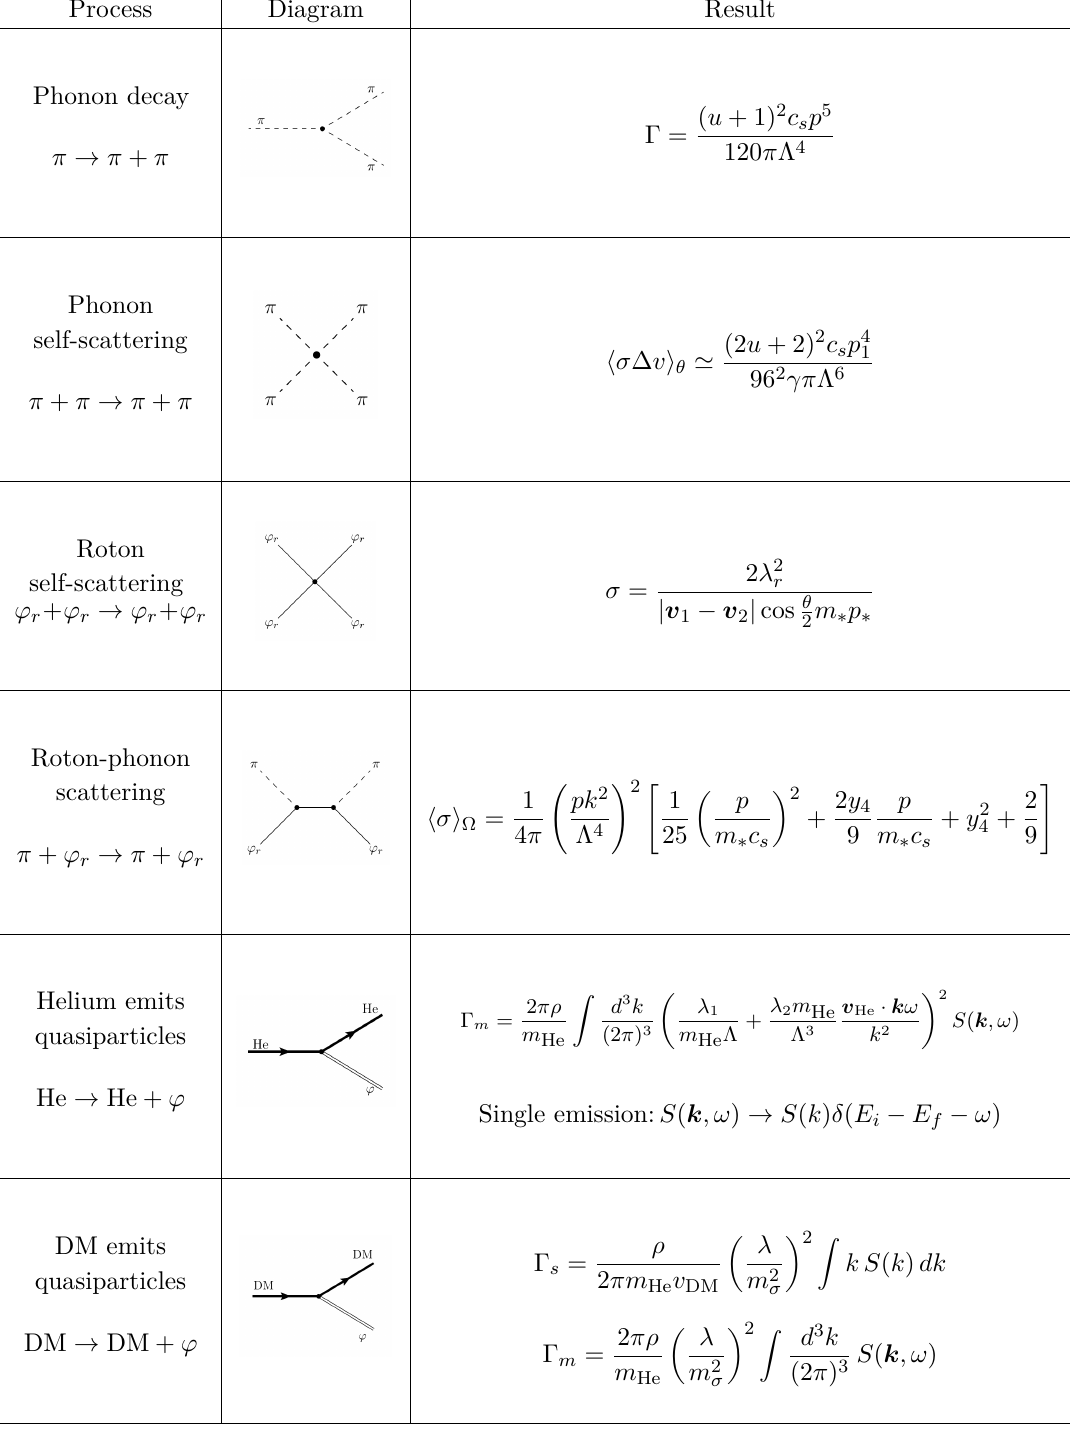
Table 1 . Summary of the main results from section 4. The UV parameter Λ has the following